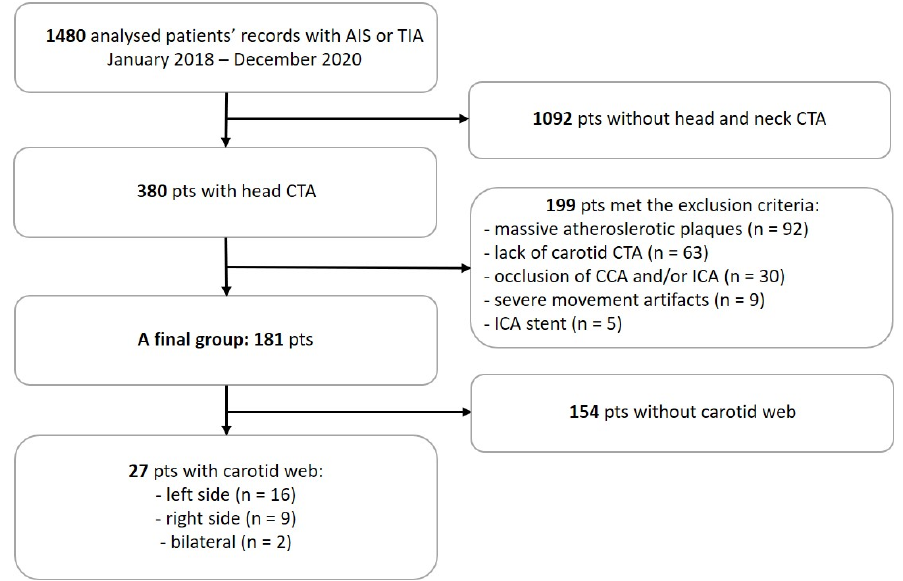
Figure 1. A final group creation process to detect carotid web in patients with AIS or TIA. AIS—acute ischemic stroke; TIA—transient ischemic attack; pts—patients; CTA—computed tomography angiography; CCA—common carotid artery; and ICA—internal carotid artery.